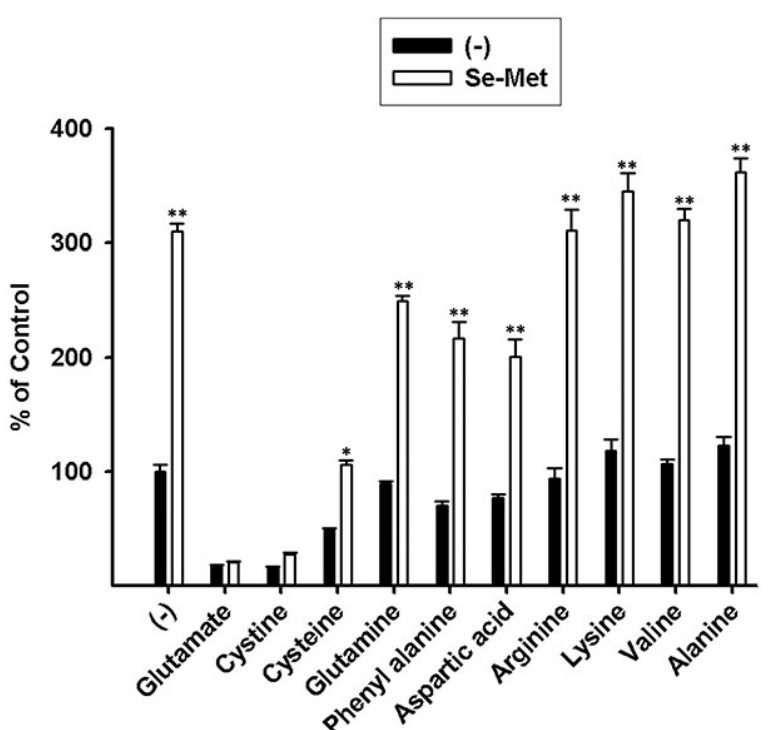
Figure 4. Substrate specificity of system xc- in control and selenomethionine (Se-Met)-treated ARPE-19 cells: uptake of [3H]-glutamate (2.5 μM) was measured in control and Se-Met-treated ARPE-19 cells in the absence of Na+ for 15 min at 37 °C and in the presence or absence of excess unlabeled amino acids, each at a concentration of 5 mM (* p < 0.01; ** p < 0.001).